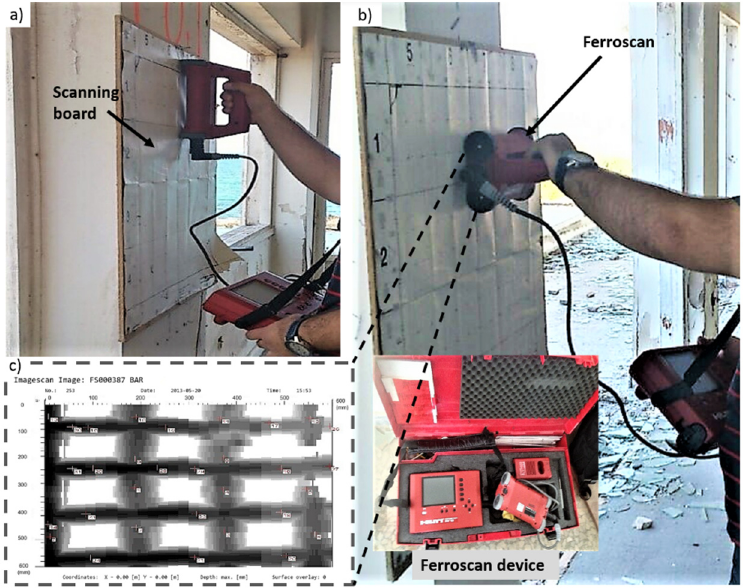
Figure 13. Covermeter (Ferroscan) and site scanning. ( a ) Scanning in vertical direction, ( b ) scanning in horizontal direction including Ferroscan device, and ( c ) a typical sample of a Ferroscan image for steel reinforcement details